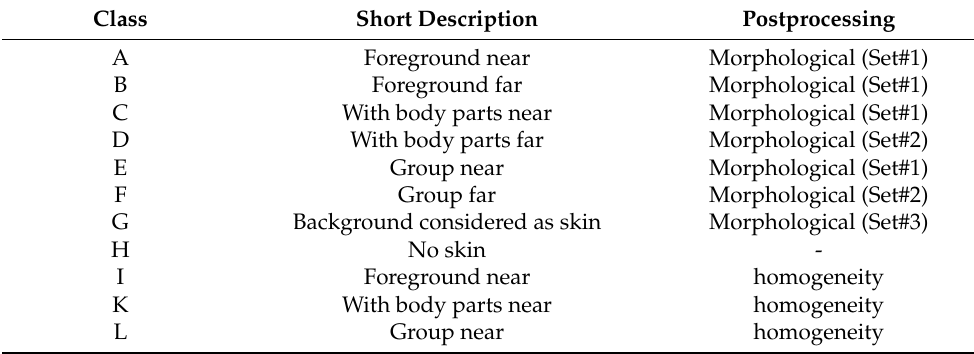
Table 1. Image classification classes and the related postprocessing methods.